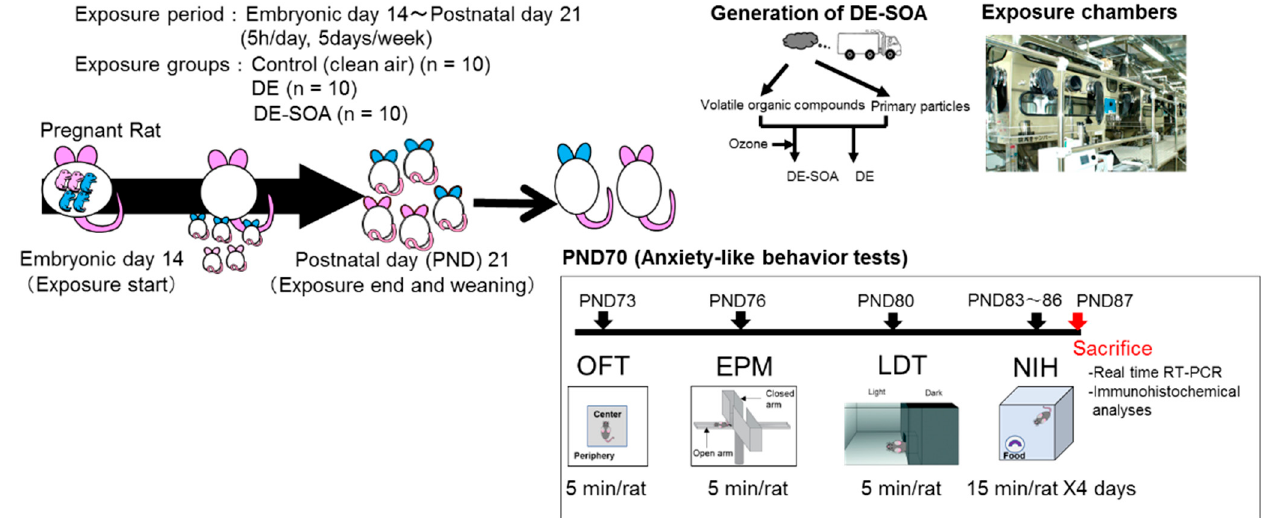
Figure 10. Experimental protocol. Pregnant Sprague Dawley rats (GD 8) were exposed to clean air (control, n = 8), DE ( n = 8), and DE-SOA ( n = 8) from GD 14 to PND 21 in whole-body exposure chambers. 10 male and 10 female rats from 3 groups (total 60) were used for the anxiety-like behavior tests, 5 male and 5 female rats from 3 groups (total 15) were used for immunohistochemical analyses. Chronological order of anxiety-like behavior tests was expressed.